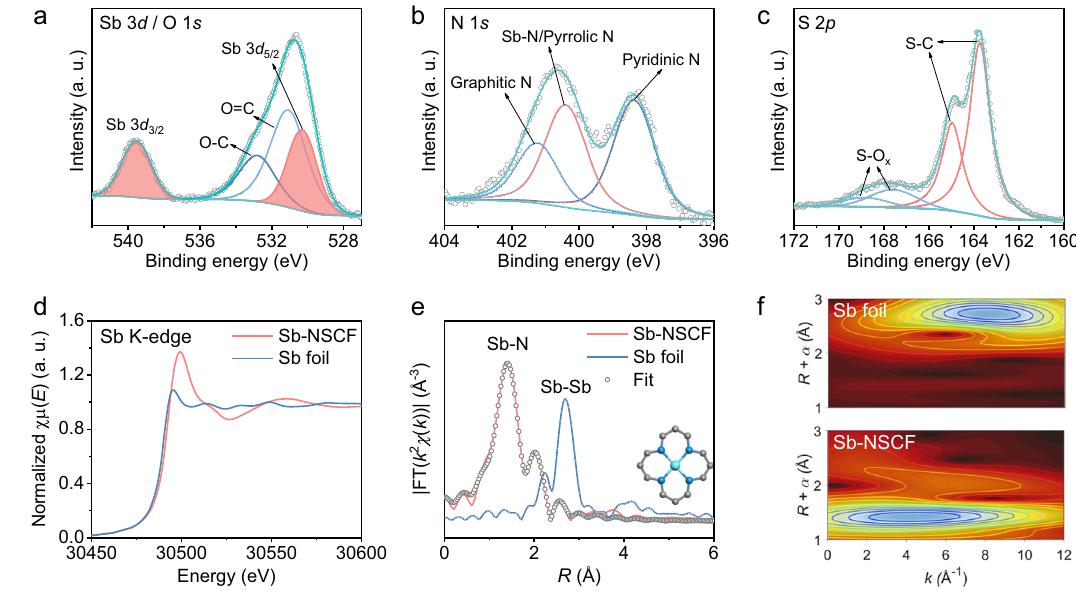
Fig. 3 | Atomic and electronic structure of Sb-NSCF. a – c High-resolution XPS spectrumofSb3 d /O1 s ,N1 s ,andS2 p ,respectively. d TheSbK-edgeXANESspectra of Sb-NSCF and Sb foil. e The k 2 -weighted FT-EXAFS spectra of different samples